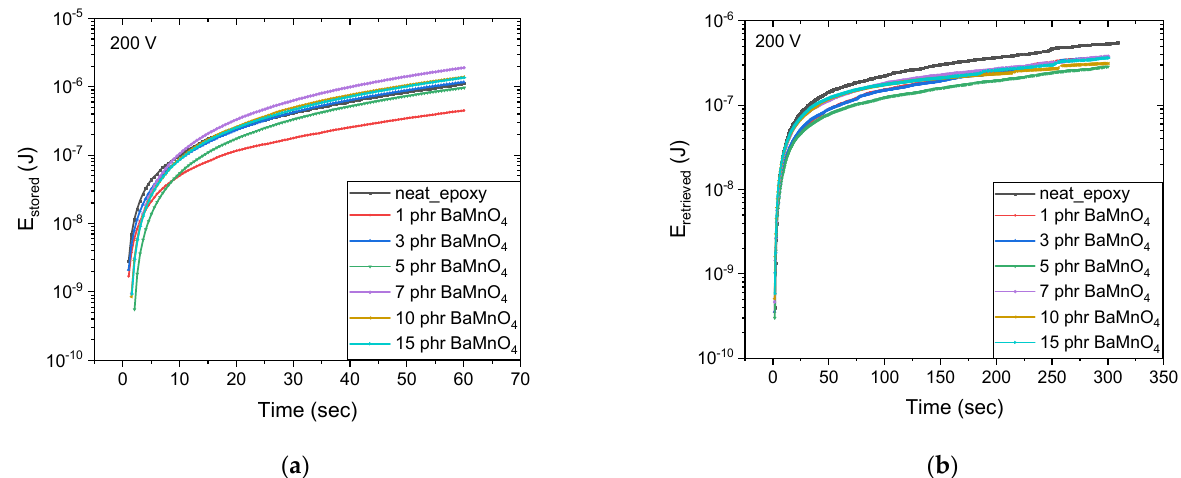
Figure 5. ( a ) Stored (charging procedure) and ( b ) retrieved (discharging procedure) energies (E stored , E retrieved ) as a function of time for all the specimens under study at a DC voltage level of 200 V. Table 1. Coefficient of energy efficiency (n eff ) and relative coefficient of energy efficiency (n eff (rel) ) of the BaMnO 4 nanocomposites at applied voltages of 50, 100, 150 and 200